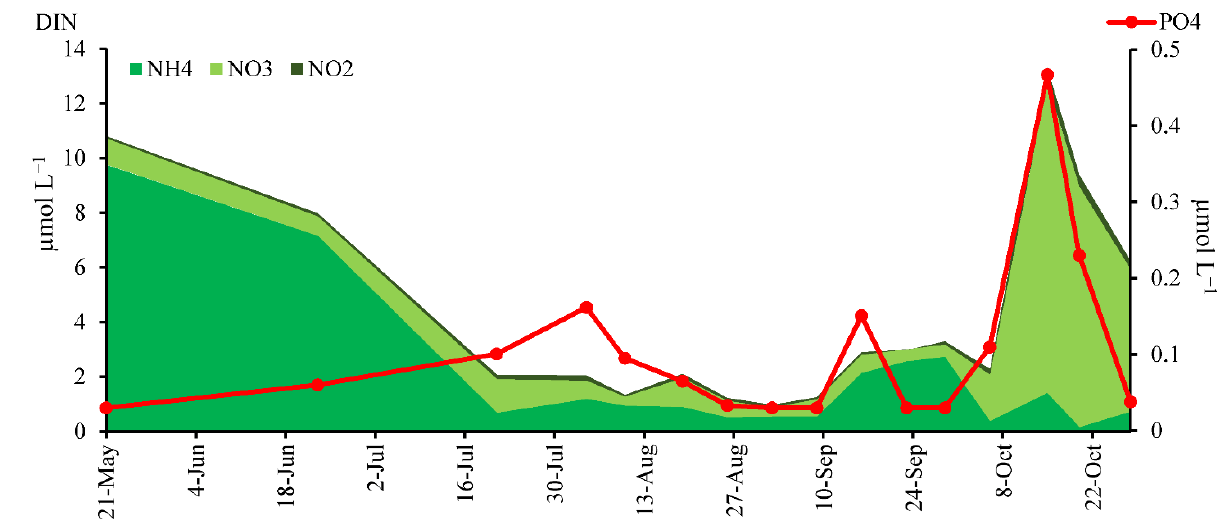
Figure 5. Trends of inorganic nutrient concentrations ( µ mol L − 1 ) at Passetto station: DIN with the details of the NO 3 − , NO 2 − , and NH 4 + contributions (left y-axis) and that of PO 4 3 − (line, right y-axis). The ratios of inorganic N:P ranged from 19 to 164 during the bloom. Values above 50 were recorded by the end of September, when the O. cf. ovata bloom was approaching its end. N:P values close to 16 (i.e., the Redfield ratio) were recorded just before the bloom ’s